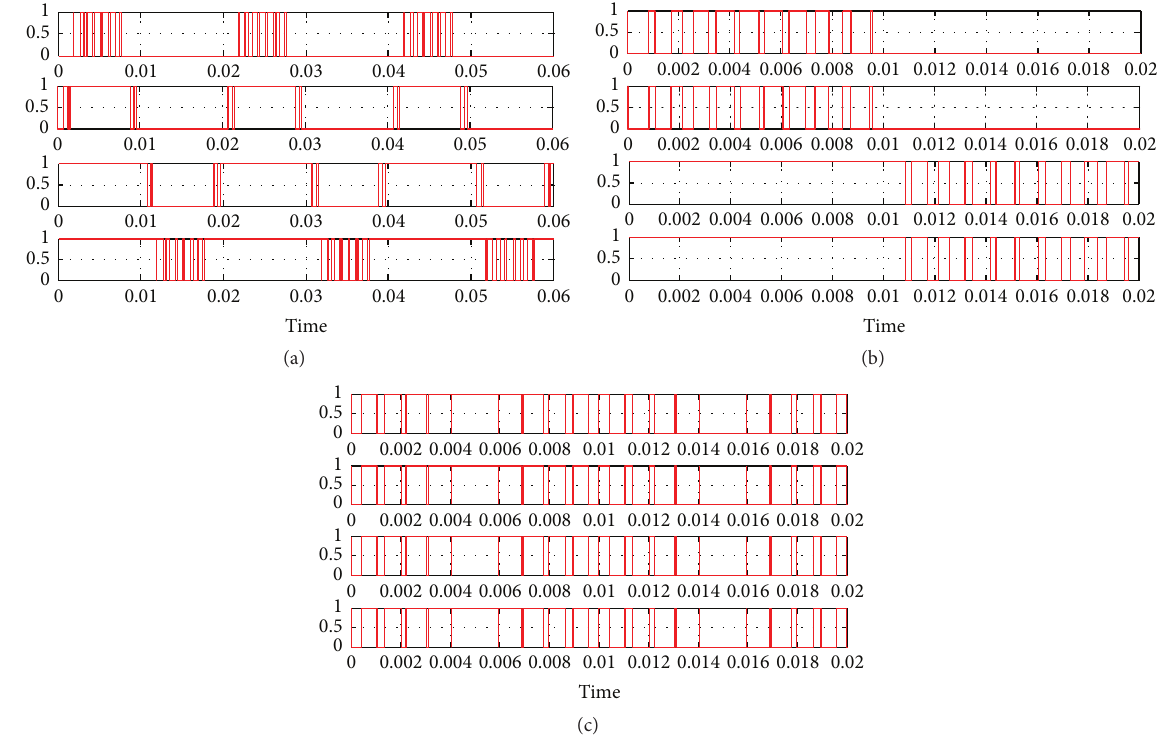
Figure 4: Simulated pulses of five-level inverter as (a) five-level inverter, (b) three-level inverter, and (c) two-level inverter.